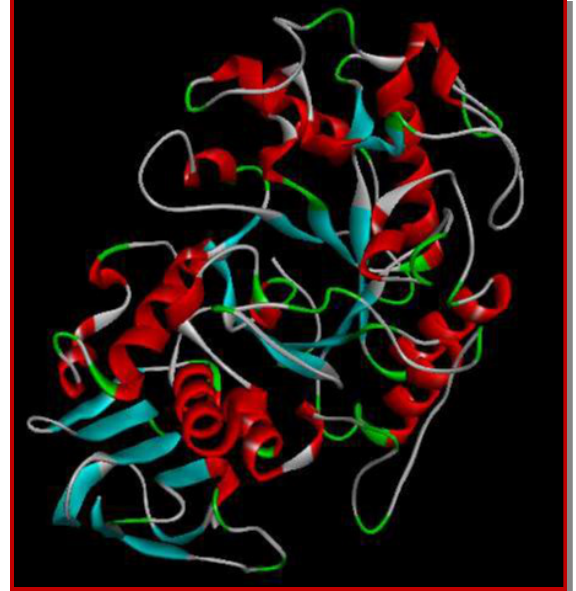
Figure 1: α-amylase enzyme from Brookhaeven protein data bank